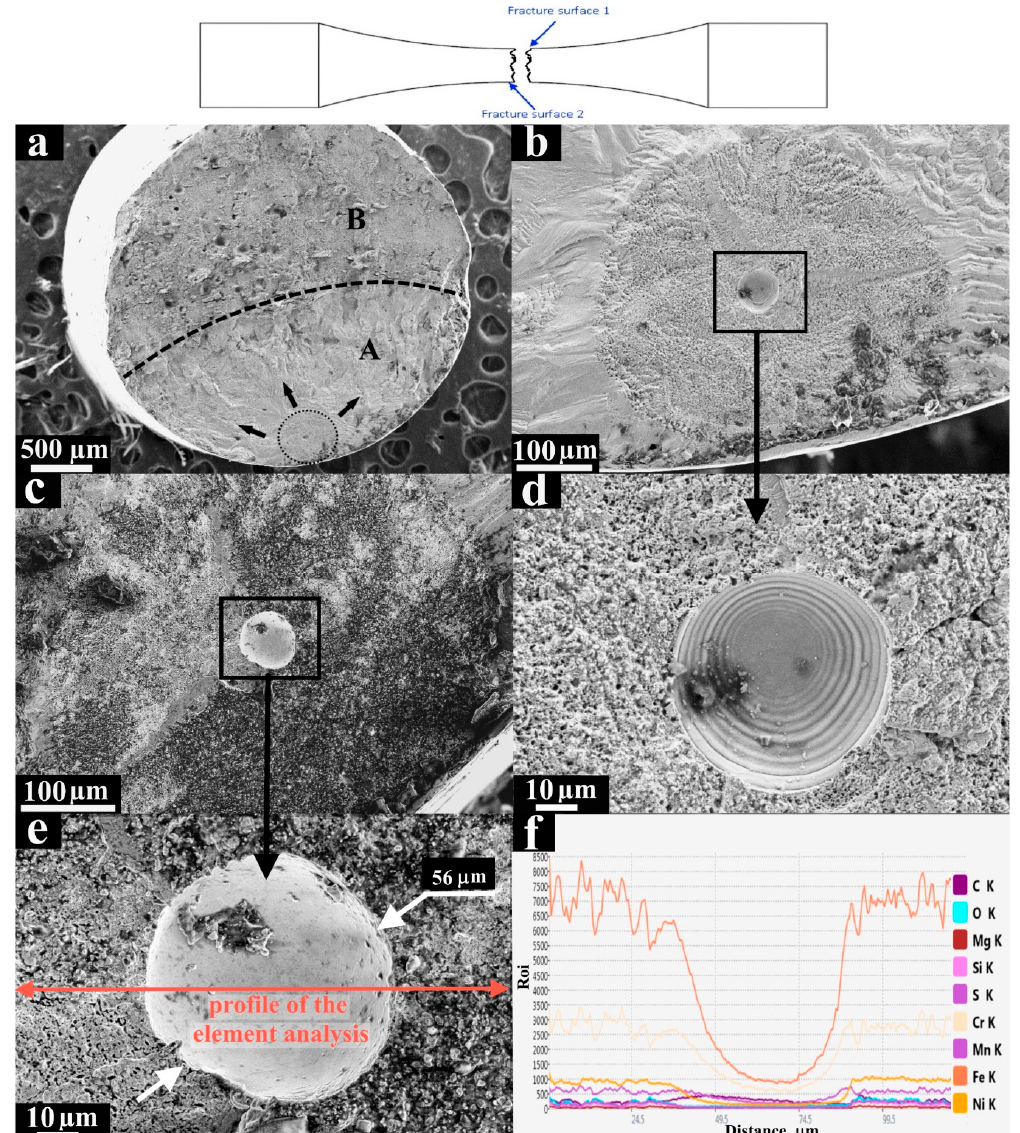
Figure 6. SEM micrographs of the fracture surfaces after loading in the very high cycle fatigue (VHCF) regime ( σ max = 270 MPa and N = 4 × 10 7 cycles) of the L-PBF specimen with the assumed nonmetallic inclusion), ( a ) fracture surface 1; ( b ) FGA and crack initiation site at fracture surface 1; ( c ) crack initiation site at fracture surface 2; ( d ) imprint of the defect at fracture surface 1; ( e ) imprint of the defect at fracture surface 2; and ( f ) element distribution across the defect and its